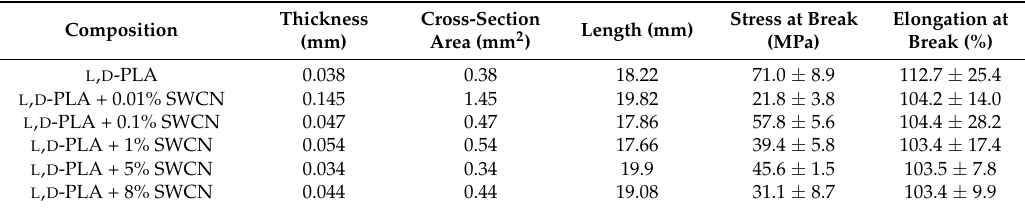
Table 2. Tensile test performance on L , D -PLA with different contents of SWCN. Composition